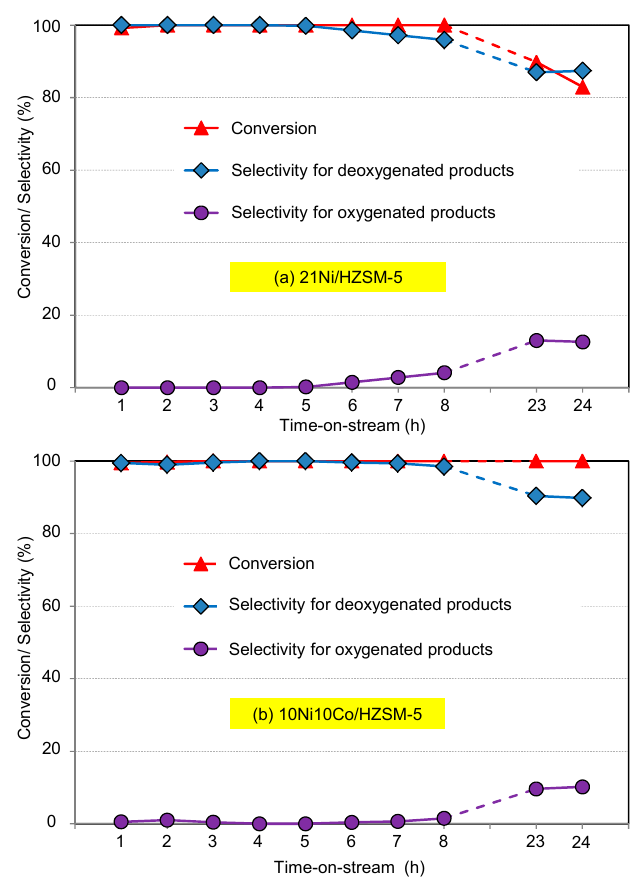
Figure 8. Phenol HDO in the continuous reactor over ( a ) 21Ni/HZSM-5 and ( b ) 10Ni10Co/HZSM-5 ( T = 250 °C, p = 60 bar, WHSV = 1.8 h − 1 , H 2 :phenol molar ratio = 28).